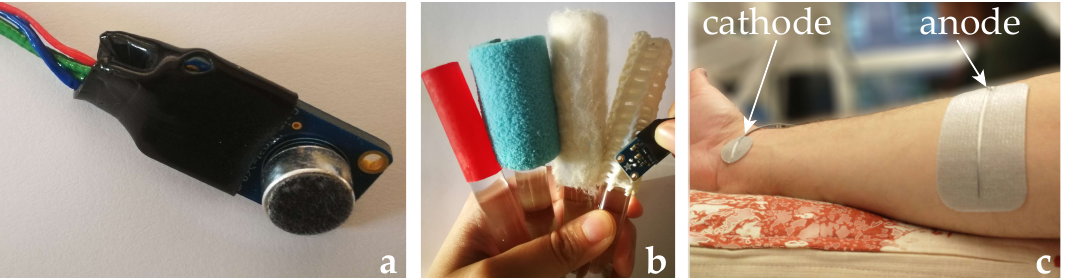
Figure 1. ( a ) Close-up image of the omnidirectional electret condenser microphone with an amplifier module. An isolation cable was put on the circuit board for an easier grip of the microphone during the stroking and to reduce interference with the components on the printed circuit board (PCB). ( b ) The experimenter was stroking the different textures with a microphone in a proximal to distal direction. ( c ) Placement of the electrodes on the participant’s forearm. The cathode was placed over the median nerve while the anode was applied on the upper part of the